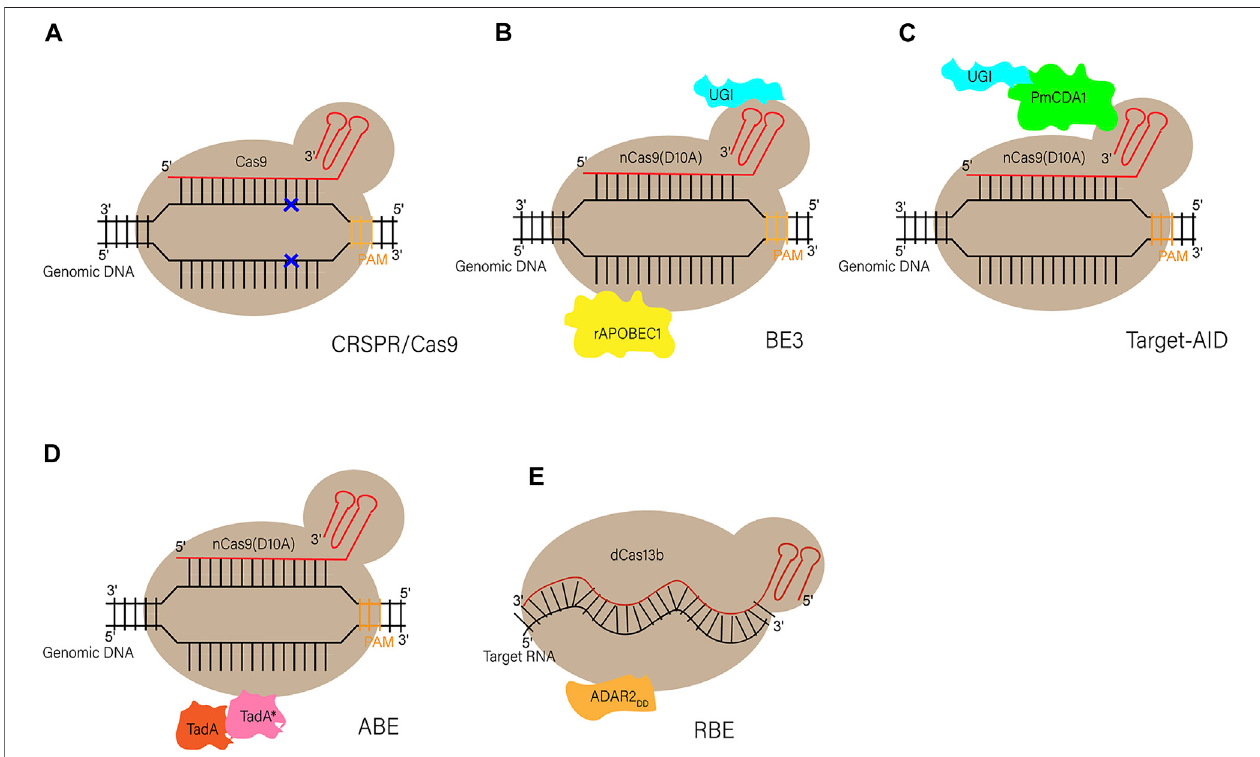
FIGURE2| SchematicdiagramofCRISPR/Cas9anddifferentBEs (A)SchematicdiagramofCRISPR/Cas9. ThroughbasepairingbetweensgRNAsandDNA as well asthe PAM sequence, Cas9 can recognize and cleave the double-strand DNAat thetargetsite to form DSBs (B,C) Schematic diagramof two originalbase editors(CBEs). BE3:aSpCas9nickase(D10A)islinkedtoaratcytidinedeaminase(rAPOBEC1)throughtheNterminus,andtoauracilglycosylaseinhibitor(UGI)atthe C terminus. Target-AID: the C terminus of SpCas9 nickase (D10A) is linked to both cytidine deaminase from Petromyzon marinus (PmCDA1) and UGI (D) Schematic diagram of adenine base editor (ABEs). ABEs: fusion of arti fi cially evolved DNA adenine deaminase (TadA*-TadA) with SpCas9 nickase (D10A) generates ABEs (TadA, wildtype Escherichia coil tRNA adenosine deaminase; TadA*, mutated TadA) (E) Schematic diagram of RNA base editor (RBEs). RBEs: catalytically dead Prevotella sp. Cas13 (dCas13b) is tethered with deaminase domain of human “ adenosine deaminase acting on RNA ” (ADAR2 DD ) to form